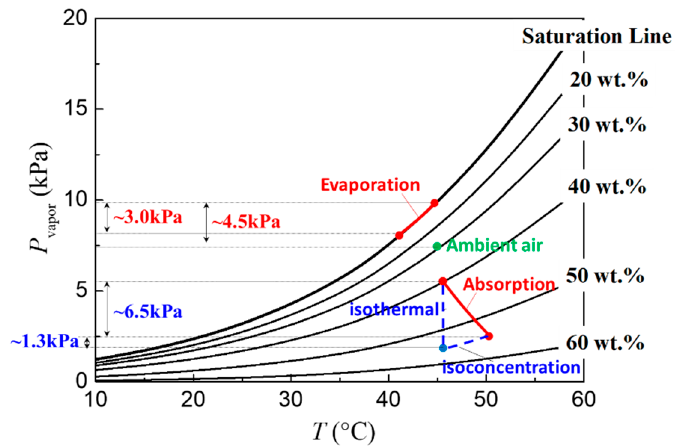
Figure 7. Evolution of water vapor pressure P vapor along with interfacial temperature for pure water droplets during evaporation and LiBr-H 2 O droplets with different solute concentrations during vapor absorption showed in red lines